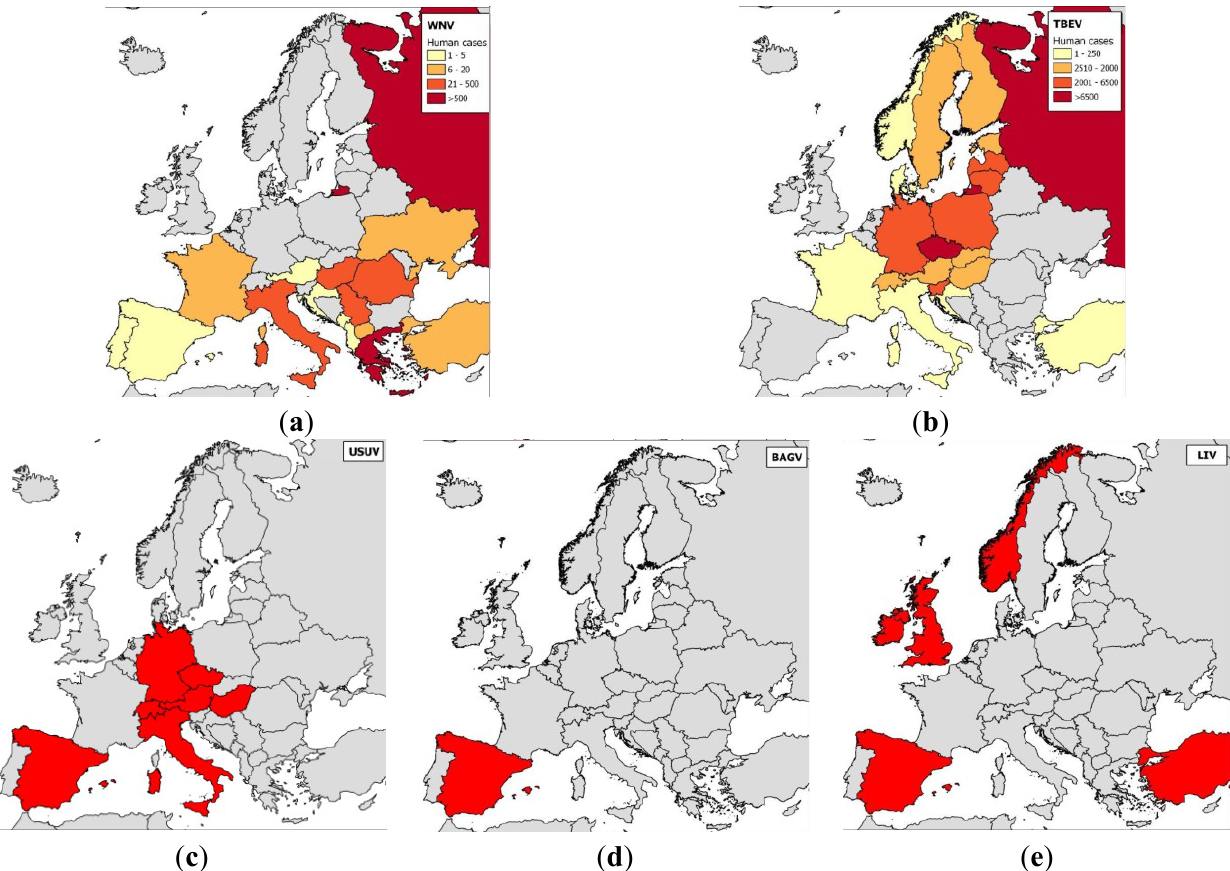
Figure 2. Maps of the distributions of the main flaviviruses found in